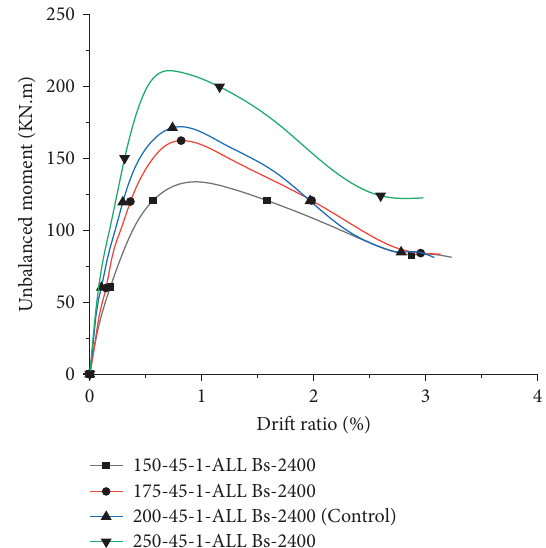
Figure 38: Efect of slab thickens on unbalanced moment drift